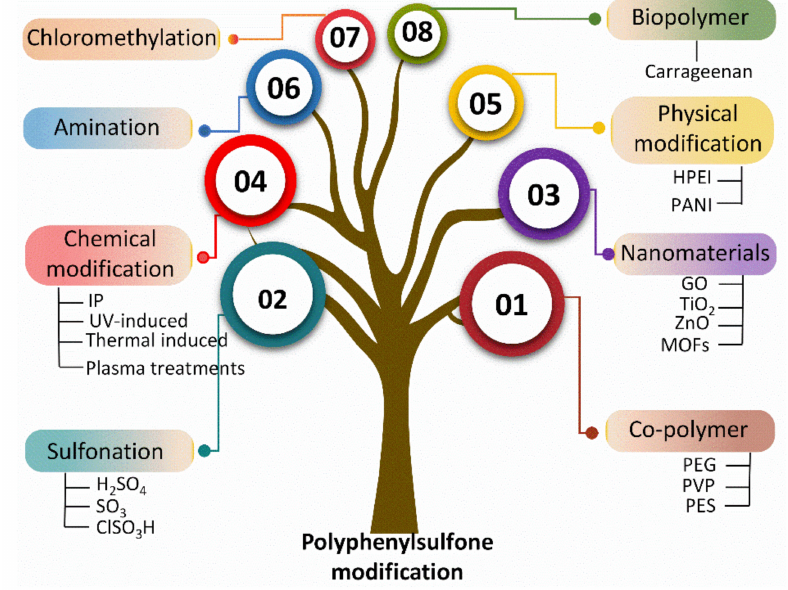
Figure 2. Modification techniques for PPSU utilizing various modifiers.